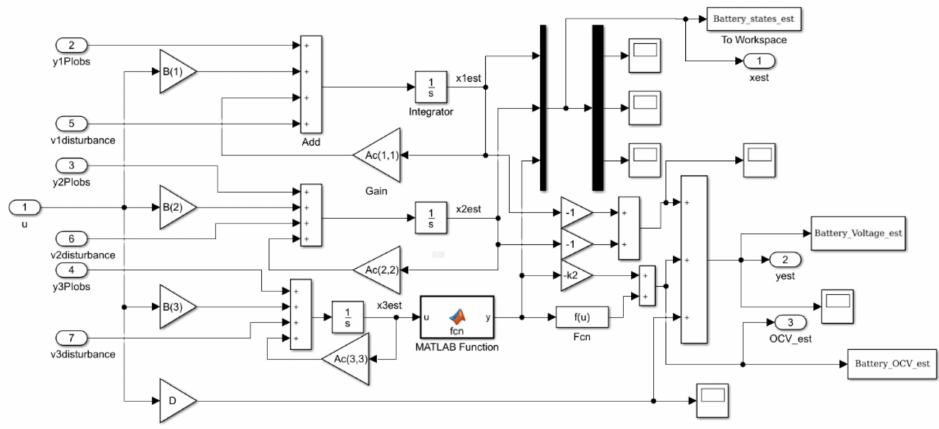
Figure 29. The architecture of Simulink models for 2RC EMC Li-Ion battery and estimator.